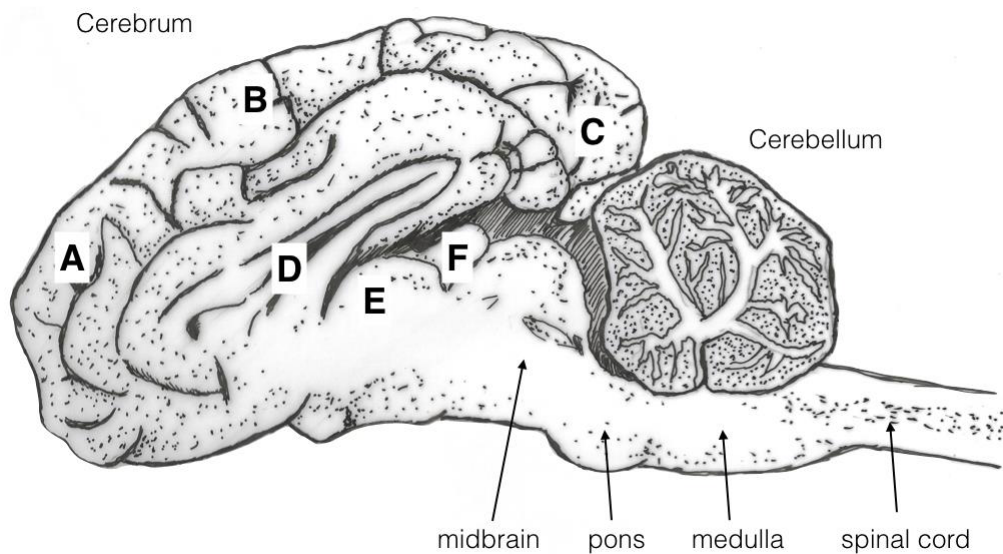
Figure 5. Sagittal diagram of a brain illustrating the areas examined for macroscopic damage. (A) frontal cerebrum, (B) parietal cerebrum, (C) occipital cerebrum, (D) lateral ventricle. These were scored on the basis of 0 = no damage, 1 = slight deformation, 2 = moderate deformation, and 3 = severe deformation of the area. The frontal (A), parietal (B), and occipital cerebrum (C), lateral ventricle (D), thalamus (E), pineal gland (F), midbrain, pons, medulla, and cerebellum were assessed for presence or absence of haemorrhage with a score of 1 indicating presence of haemorrhage and 0 the absence of haemorrhages.